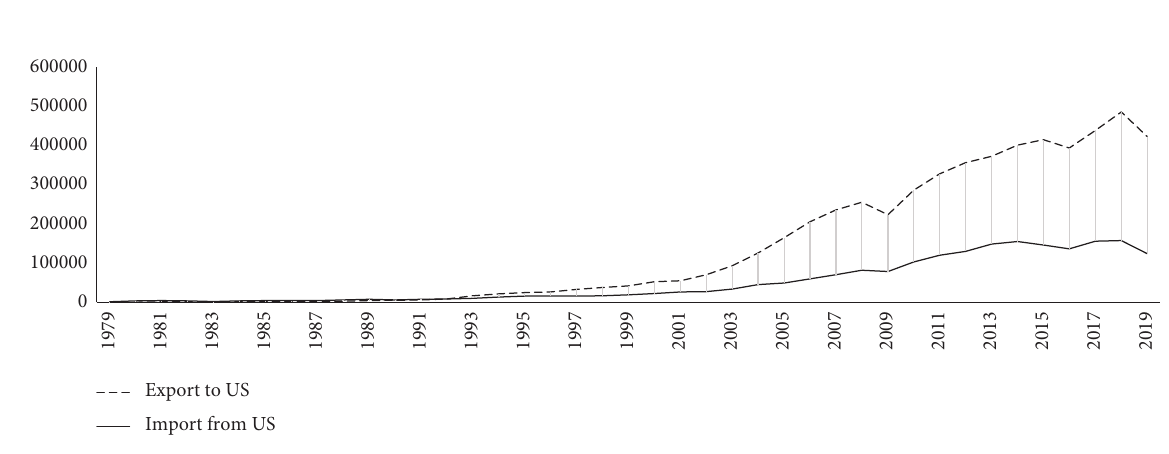
Figure 5: Share of the United States’ trade with China in the United States’ total trade (1979–2019). Source: the IMF direction of trade statistics [23]. (a) 1979–2000. (b) 2001–2019.